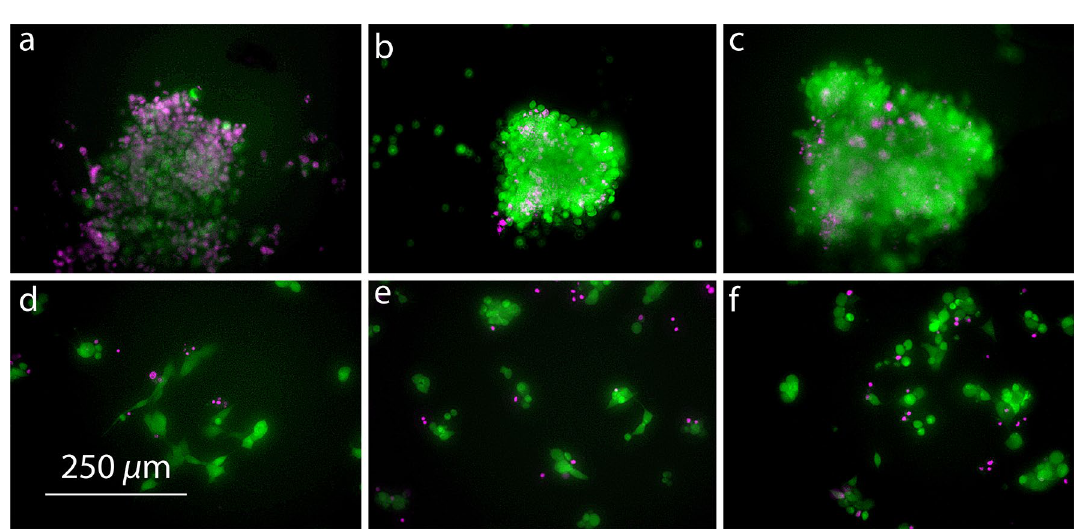
Figure 2. Live(green)/dead(purple) stain of MCF7 cells cultured under hypoxic conditions as a spheroid ( a–c ) and as an adherent monolayer ( d–f ) after 48 h. The seeding number increases from left to right with 1250 cells ( a,d ), 1800 cells ( b,e ), and 2500 cells ( c,f ) in 2.5 µ L. Scale bar is the same for all the micrographs in this